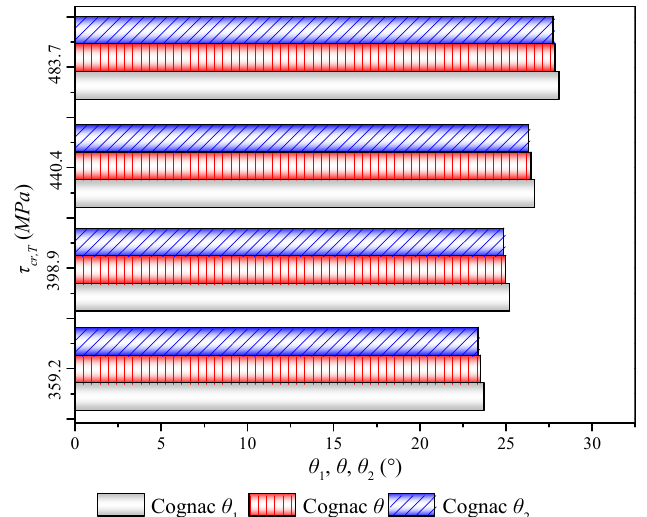
Figure 11. Different angles θ 1 , θ and θ 2 versus corrugation height h r ( R = 110 m).